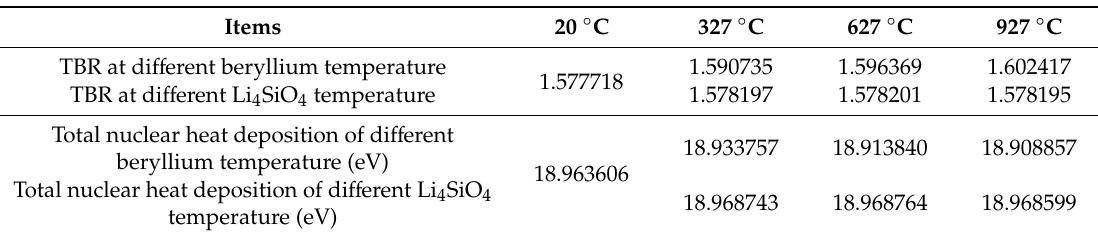
Table 9. Neutronics results of the HCSB blanket with considering the S ( α , β ) data at di ff erent materials